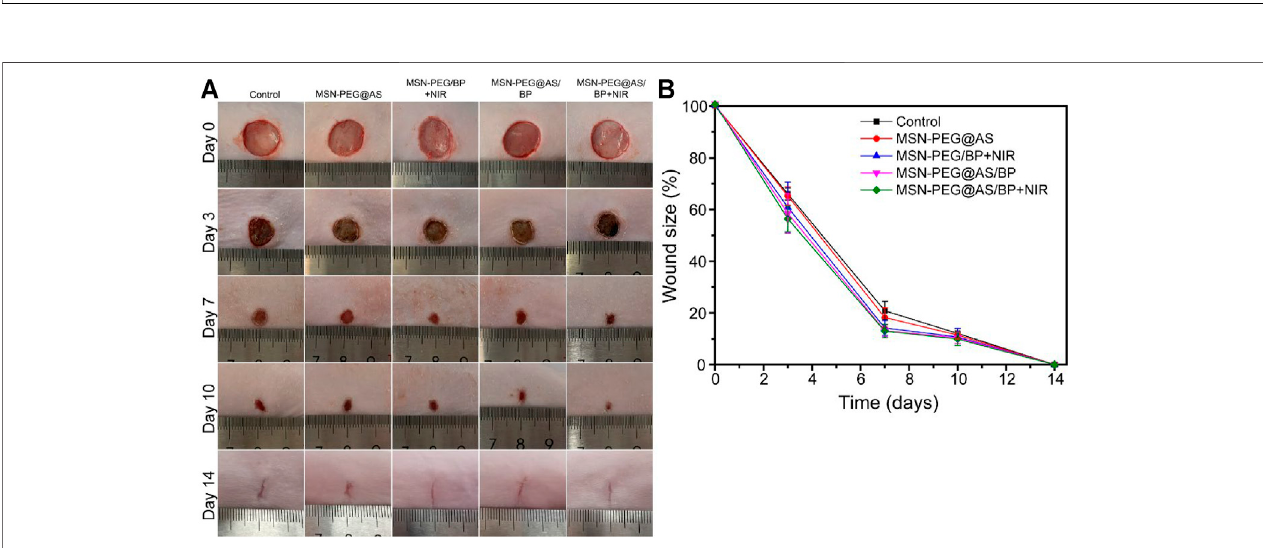
FIGURE4|(A) Digitalimageofwoundhealingatday0,3,7,10,and14withdifferenttreatments. (B) Quanti fi cationofwoundclosurerate(Control,MSN-PEG@AS, MSN-PEG@BP + NIR, MSN-PEG@AS/BP, and MSN-PEG@AS/BP +